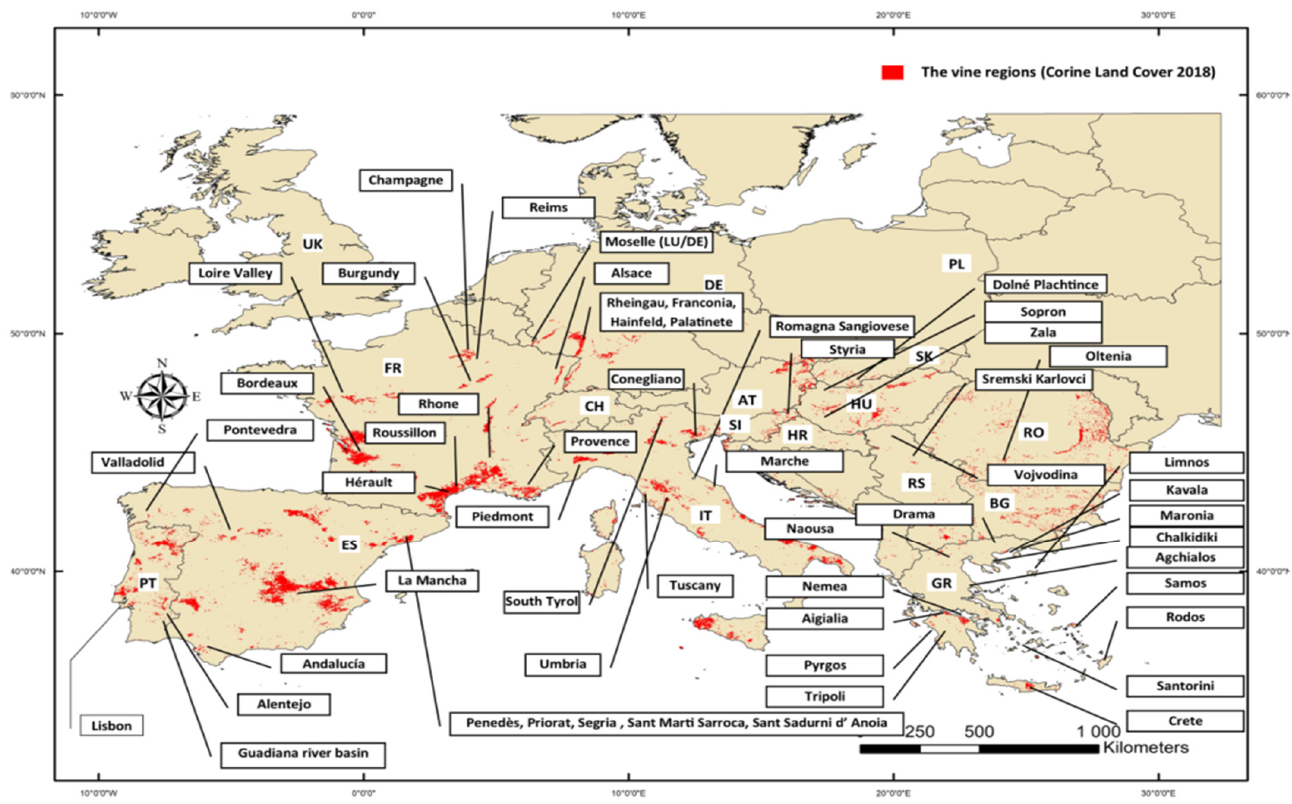
Figure 2. The vine regions reviewed. The viticultural regions not detected by the CLC (Corine Land Cover) 2018 are not displayed.